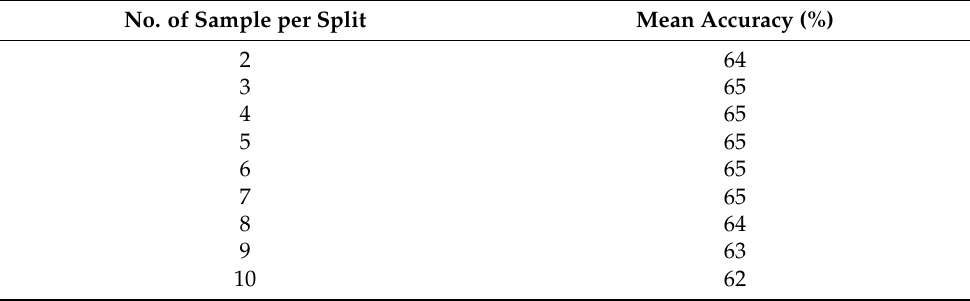
Table 5. Ecuador:Predictive accuracy score against number of samples per